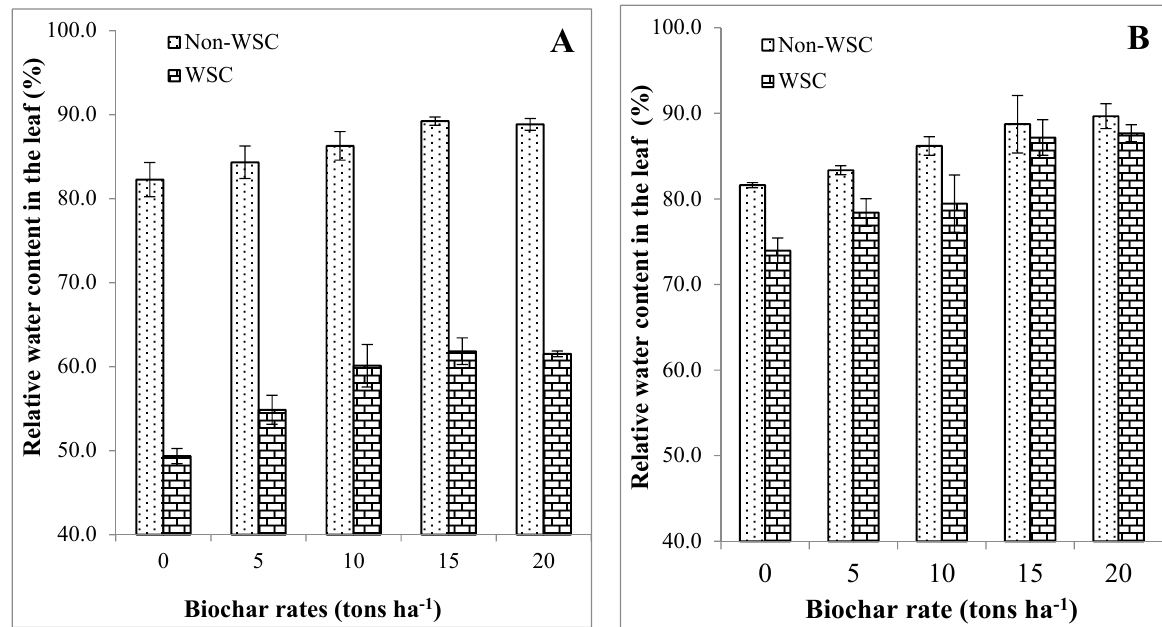
Figure 4. Effect of biochar on leaf relative water content of Ehretia asperula after 10 days without irrigation ( A ) and 10 days after re-watering ( B ). Vertical bars represent the mean ± SD, n = 9.